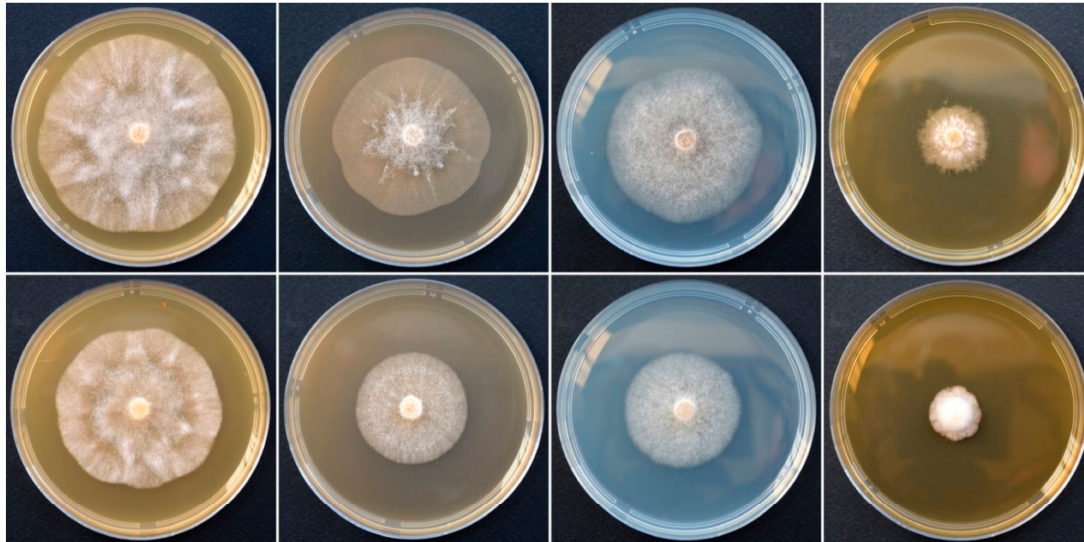
Figure 6. Colony morphologies of Phytophthora heterospora (upper row; isolate PH054) and P. palmivora (bottom row; isolate CBS 179.26) after 4 days growth at 20 ◦ C in the dark on CA, V8A, PDA, and MEA (from left to right).